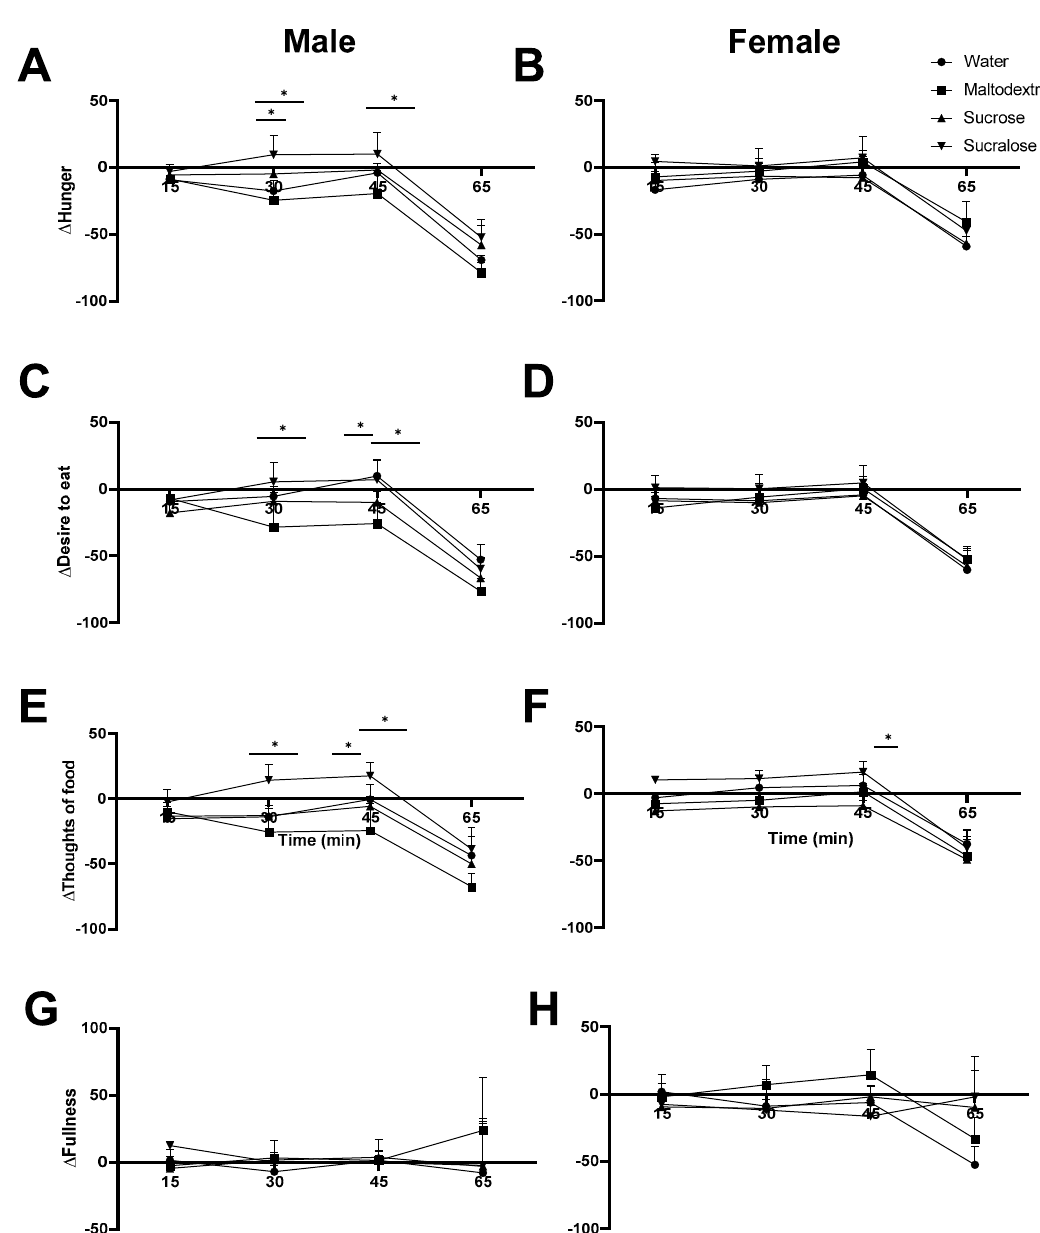
Figure 5. Di ff erence from baseline ( ∆ ) of hunger, desire to eat, thoughts of food and fullness in male ( A , C , E , G ) and female ( B , D , F , H ) panelists respectively. Bars represent mean plus SEM. Stars denote statistical significance, * p < 0.05.